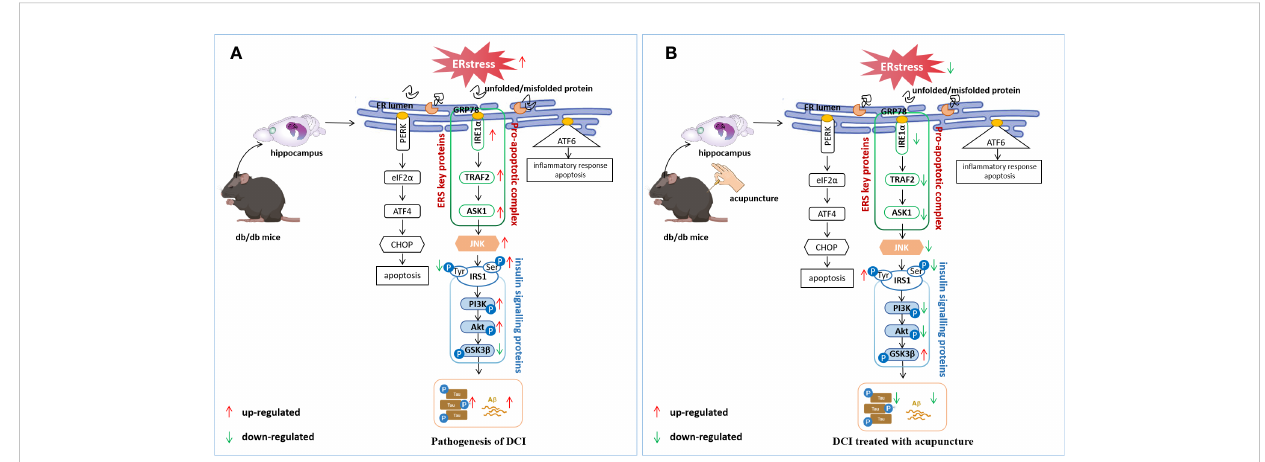
FIGURE 7 Potential regulatory mechanisms of DCI by acupuncture. (A) ERS induces an unfolded protein response that dissociates GRP78 from IRE1 a and activates JNK, leading to abnormal insulin signalling pathway transduction, increasing the expression of p-tau and A b ; (B) Electroacupuncture improves cognitive impairment by regulating hippocampal ERS levels in db/db mice, inhibiting JNK activation, restoring normal insulin signalling pathway transduction, and causing a reduction in p-Tau and A b